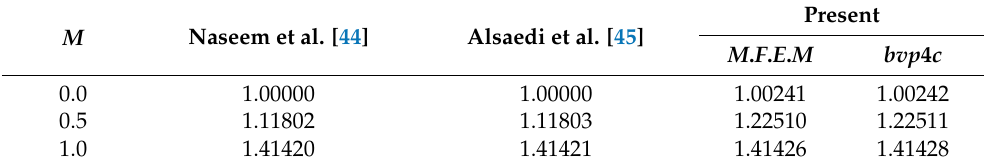
Table 1. List the numerical values of − f (cid:48)(cid:48) ( 0 ) using β → ∞ , λ = F r = E 1 = 0. M